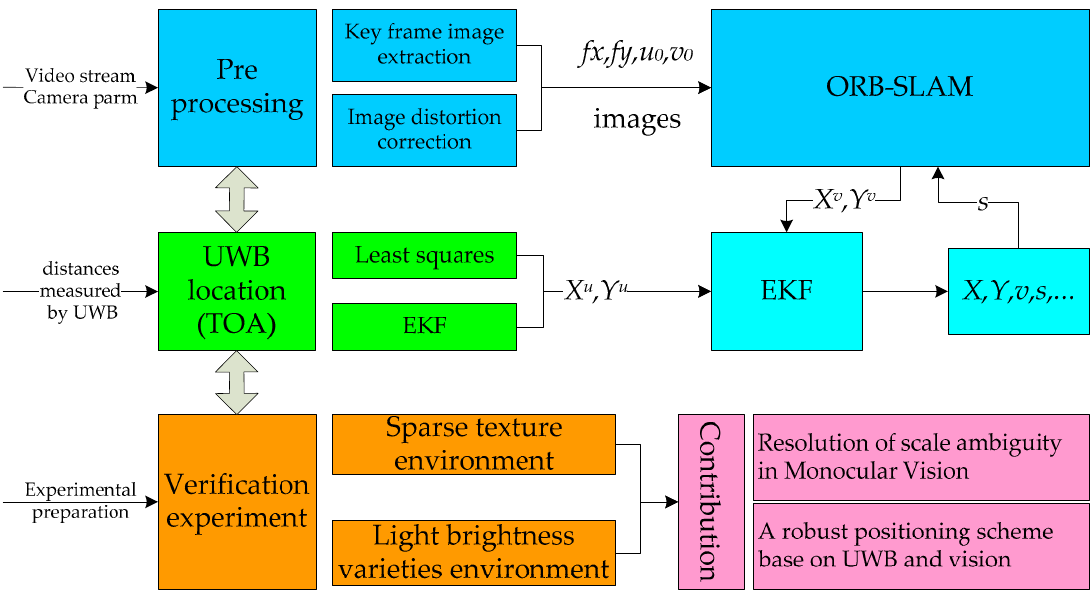
Figure 1. The technology roadmap.